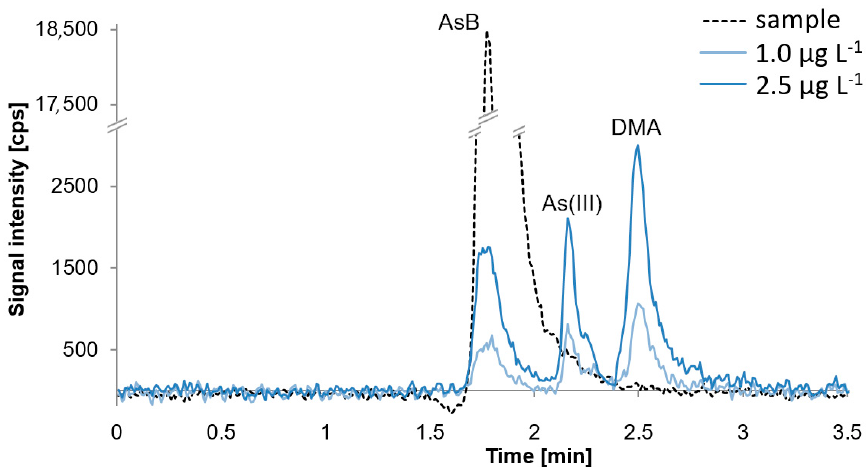
Figure 3. Chromatogram presenting selected fish sample with the concentration of AsB equal to 4.5